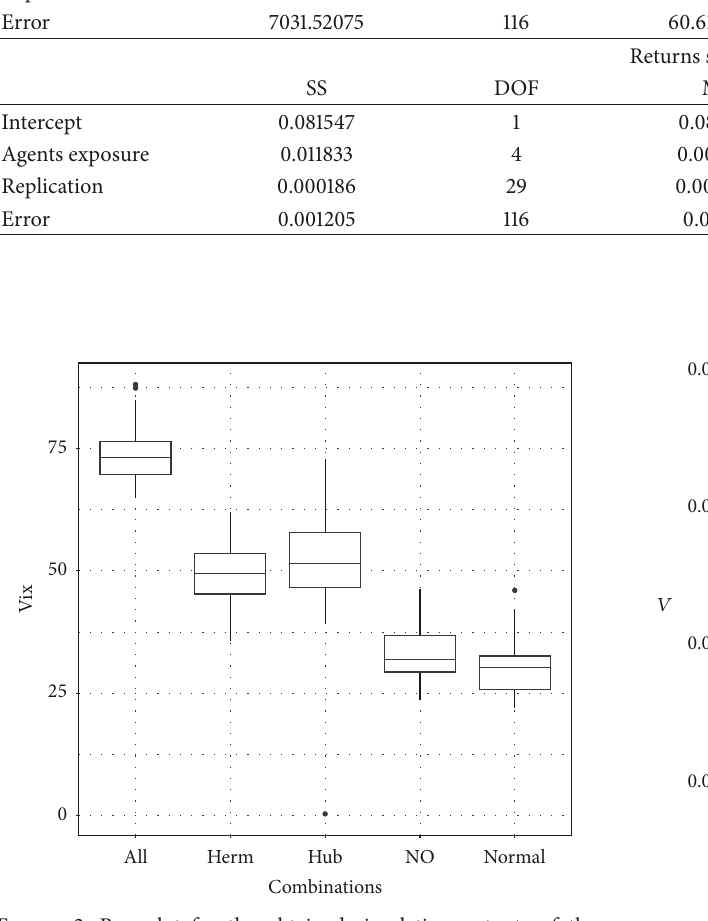
Figure 2: Box plot for the obtained simulation outputs of the maximum level of volatility index.